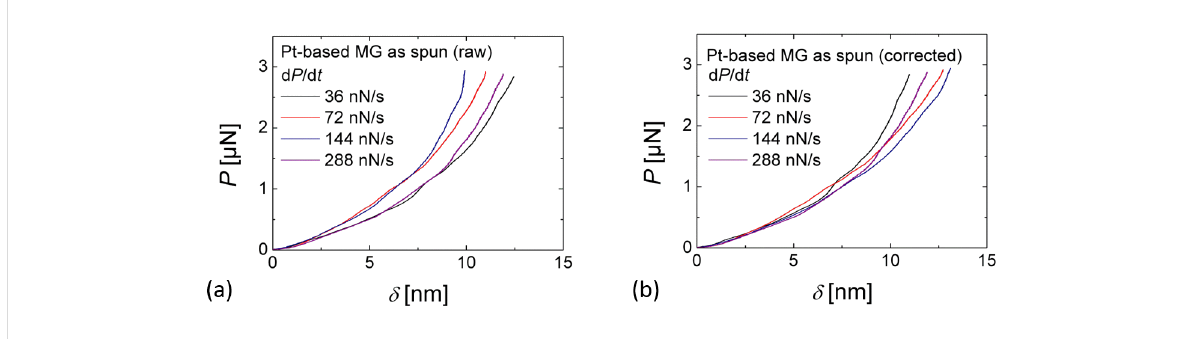
Figure 2: Series of rate-dependent AFM indentation curves (a) before and (b) after drift correction; the drift velocity difference with respect to the fastest measurements were Δ v = − 19.5, 46, and 170 pm/s for d P /d t = 36, 72, and 144 nN/s, respectively.